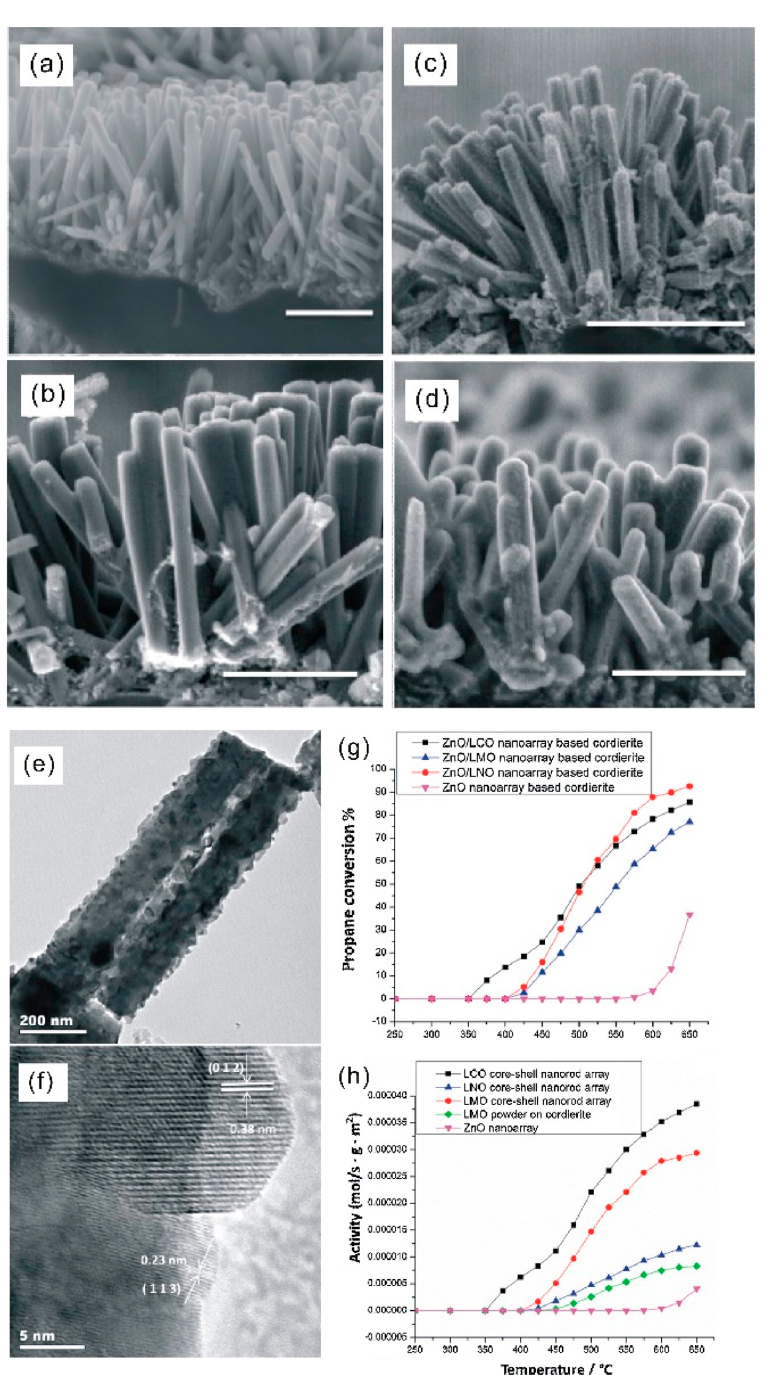
Figure 12. SEM cross-section view of ( a ) ZnO nanorod arrays rooted on monolithic cordierite substrate; ( b ) ZnO/LMO; ( c ) ZnO/LCO; and ( d ) ZnO/LNO core-shell nanorod array catalysts. Scale bars in SEM images are 1 µ m. ( e ) Bright field TEM and ( f ) HRTEM images of ZnO/LCO core-shell nanorods; ( g ) Propane oxidation over ZnO and ZnO/perovskite nano-array catalysts; ( h ) Activity of perovskite catalysts shown as a function of temperature. Reprinted with permission from [15], Copyright Elsevier,